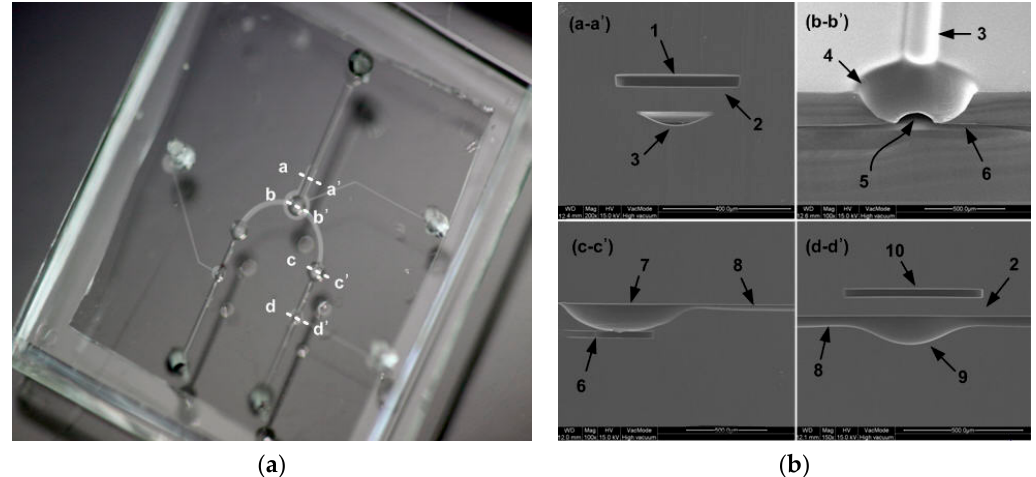
Figure 4. The pneumatically driven microfluidic platform that concentrates particles. ( a ) Fabricated device, ( b ) scanning electron micrographs (SEMs) of device cross sections ( a-a’ : the particle collection region, b-b’ : Vs, c-c’ : the interconnection chamber, d-d’ : the Vp valve, 1 : pneumatic chamber for particle collection, 2 : the valve diaphragm, 3 : the curved particle collection channel, 4 : the curved fluid Vs chamber, 5 : the interconnection port, 6 : the interconnection channel, 7 : the interconnection chamber, 8 : the curved fluid channel to the outlet port, 9 : the fluid chamber for Vp (Vf), 10 : the pneumatic chamber for Vp (Vf)). Table 1. Device dimensions (W: width, D: diameter, H: height).